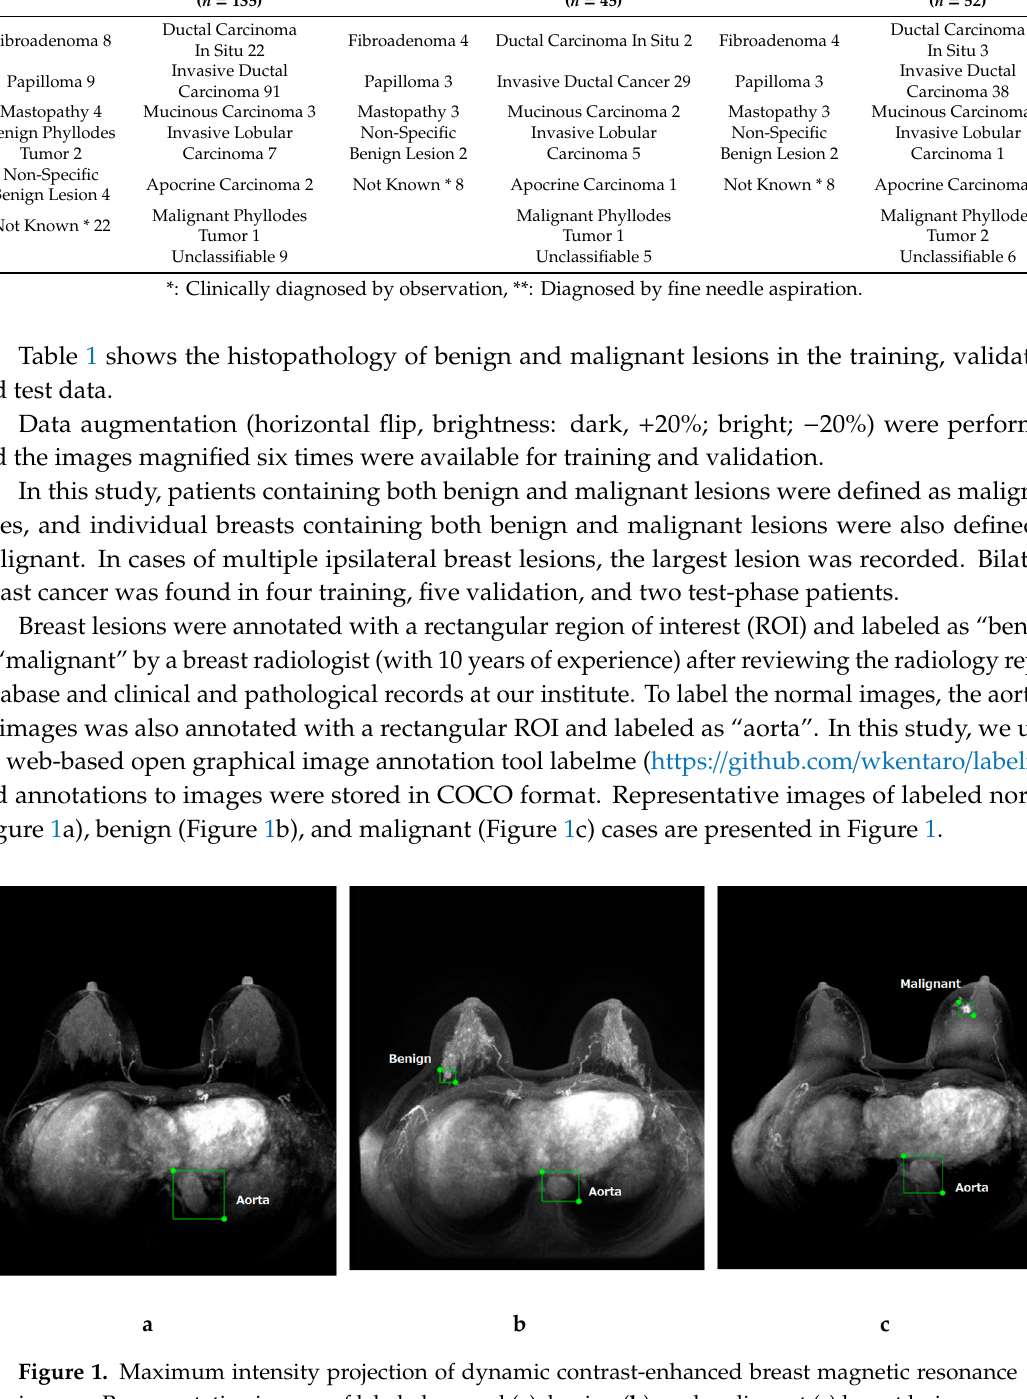
Table 1. Histopathology of benign and malignant lesions.